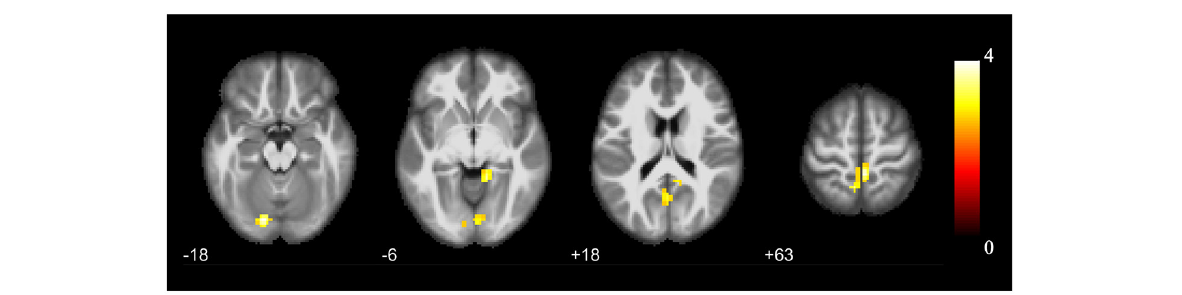
increase in ALFF in the right fusiform gyrus (Fusiform_R) and left parahippocampal gyrus (ParaHippocampal_L) as shown in Figure 3A and Table 4 . With a less strict threshold (voxel-level uncorrected P < 0.005, cluster size > 50), the HIV + HoM exhibited a decrease in regional homogeneity in the right anterior cingulate and paracingulate gyri (Cingulate_Ant_R), and left superior cerebellum (Cerebelum_Crus1_L) as shown in Figure 3B and Table 5